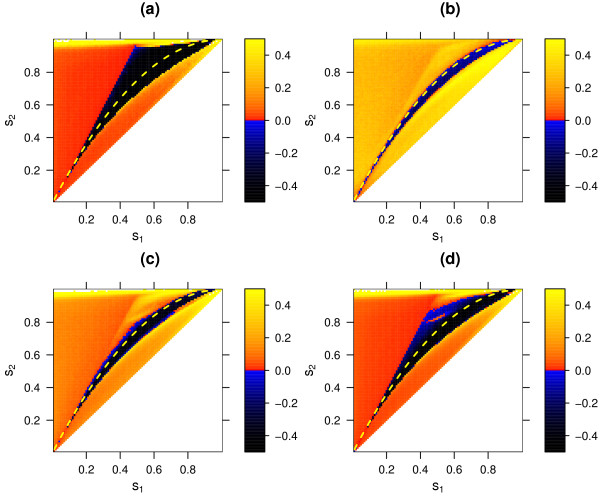
Selective advantage of sexual over asexual reproduction (rmm = 0, rmM = 0, rMM = 0.1) in the sequential-updating model for different interaction matrices, simulated deterministically (a) and stochastically with populations sizes N = 1000 (b), N = 10 000 (c), and N = 100 000 (d). For further details see legend of figure 5.